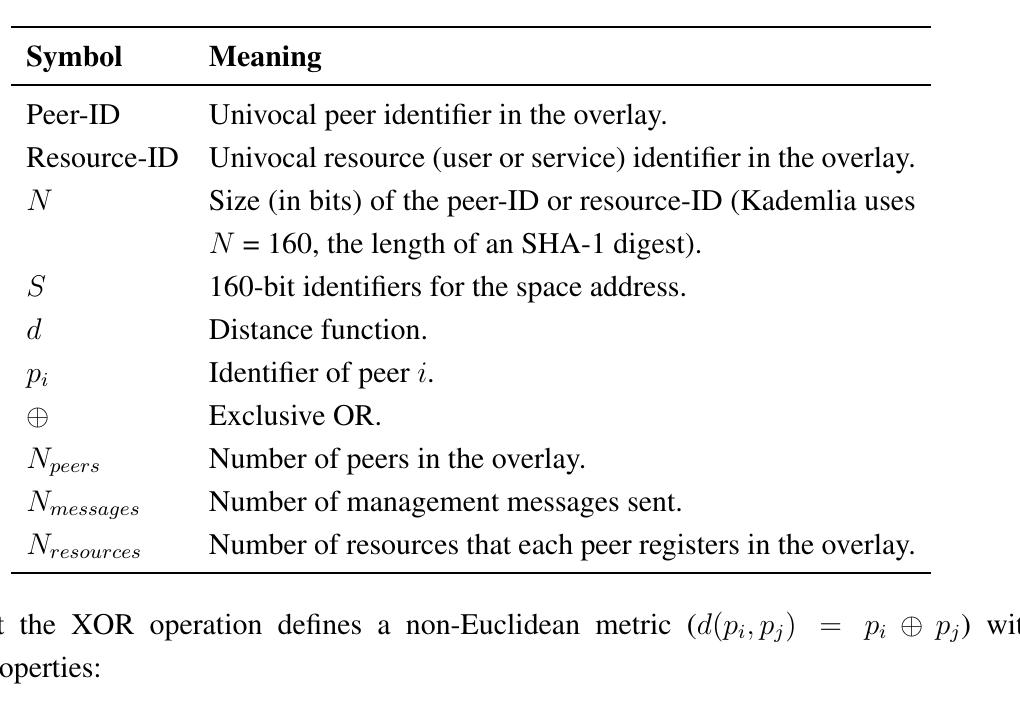
Table 1. Variable and function